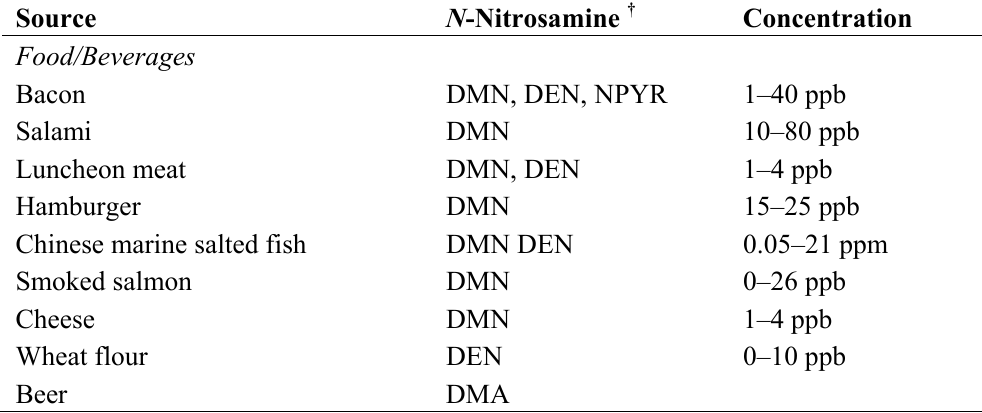
Table 1. Common Sources of N